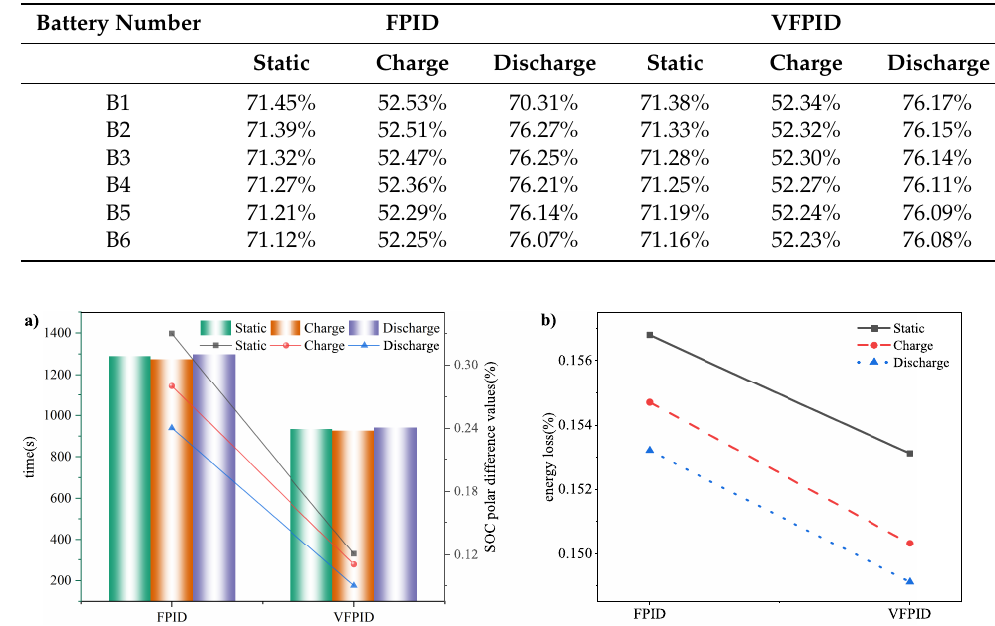
Figure 18. Comparison of equilibrium results: ( a ) Equalization time and SOC polarization value; ( b ) Energy